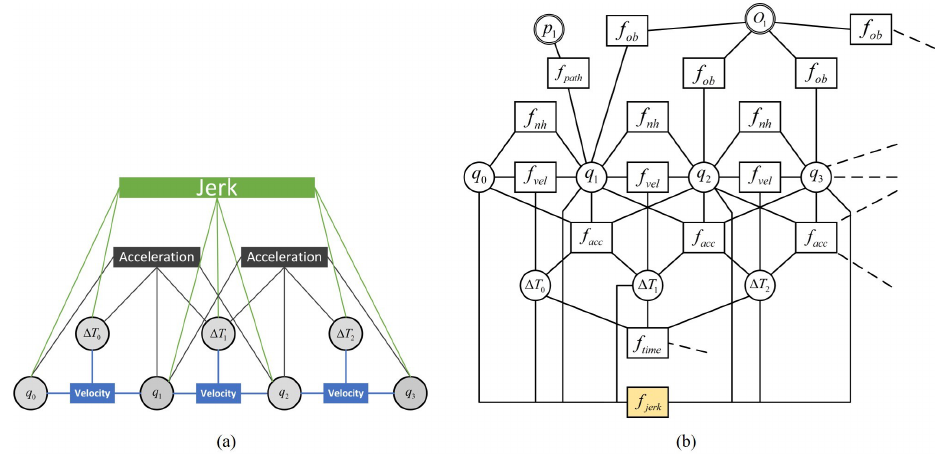
Figure 3. ( a ) A minimum hyper-graph considering jerk. ( b ) A simplified structure of the NRTEB hyper-graph. Circles represent optimized vertices and rectangles represent constrained hyperedges. Every seven adjacent vertices have a jerk super-edge, thus limiting the jerk of the whole